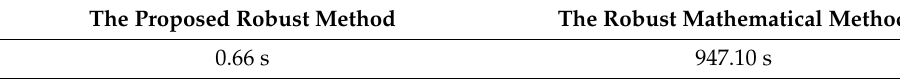
Table 3. Computational Time for 365